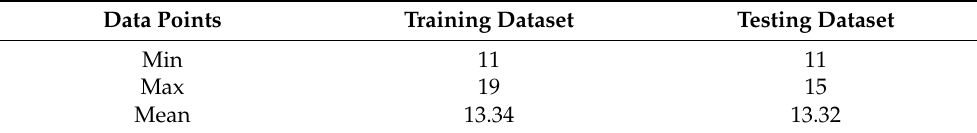
Table 2. Statistical results of the data samples (raw